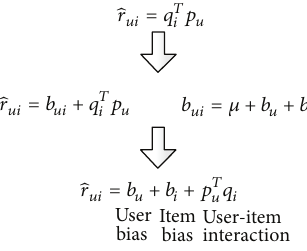
Figure 1: User rating